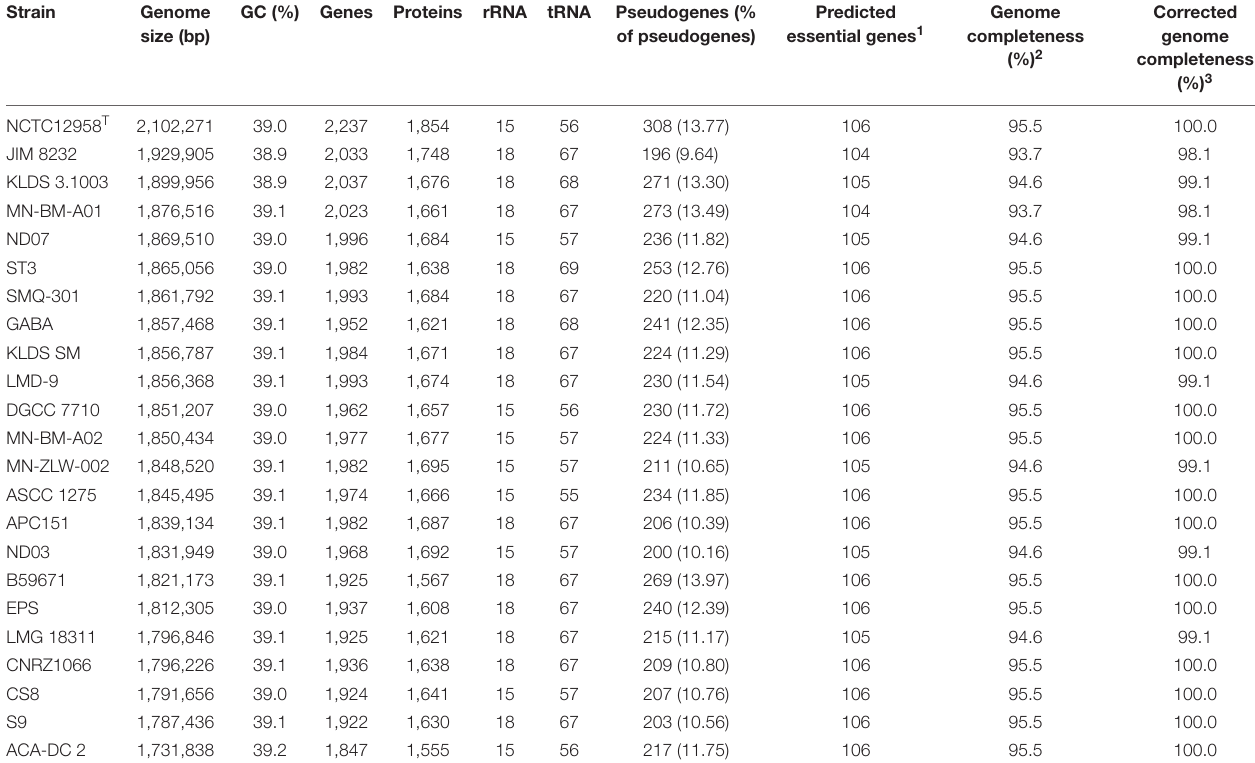
TABLE 2 | General genome features of S. thermophilus strains with complete genomes analyzed in this study. Strain Genome GC (%) Genes Proteins rRNA tRNA Pseudogenes (% size (bp)